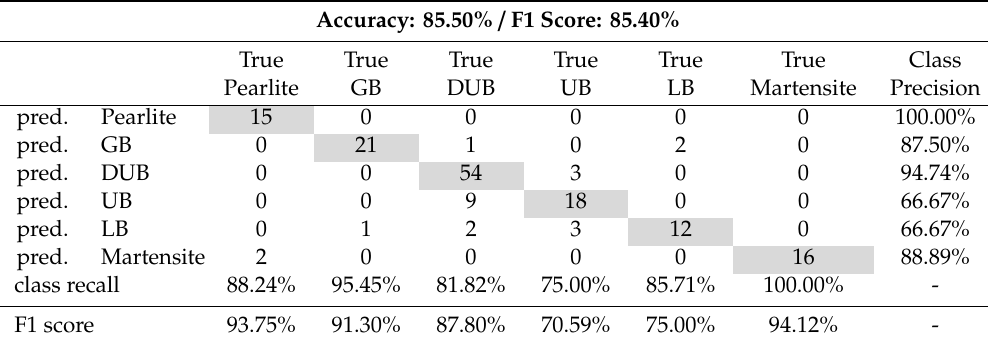
Table 3. Confusion matrix for the classification using Haralick textural parameters with a quadratic kernel support vector machine